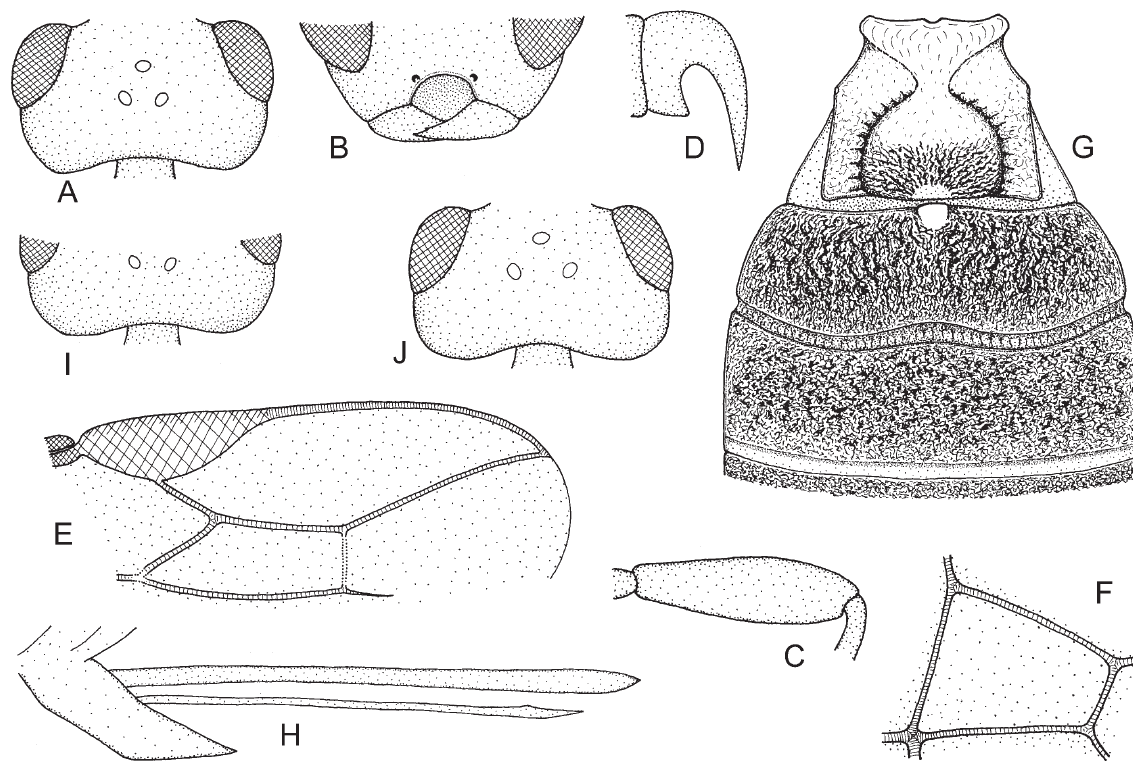
Fig. 33. — A-I . Bracon ( Bracon ) pectoralis Wesmael, 1838 (A-G: ♀ lectotype, H: ♀ paralectotype, I: ♂ paralectotype). A . Head in dorsal view. B . Head in frontal view. C . Hind femur. D . Claw. E . Distal part of right forewing. F . First discal cell of right forewing. G . Tergites 1-3. H . Hypopygium and ovipositor apparatus. I . Hind half of head in dorsal view. — J . Bracon ( Bracon ) luteator Spinola, 1808, ♀ / ♂, head in dorsal